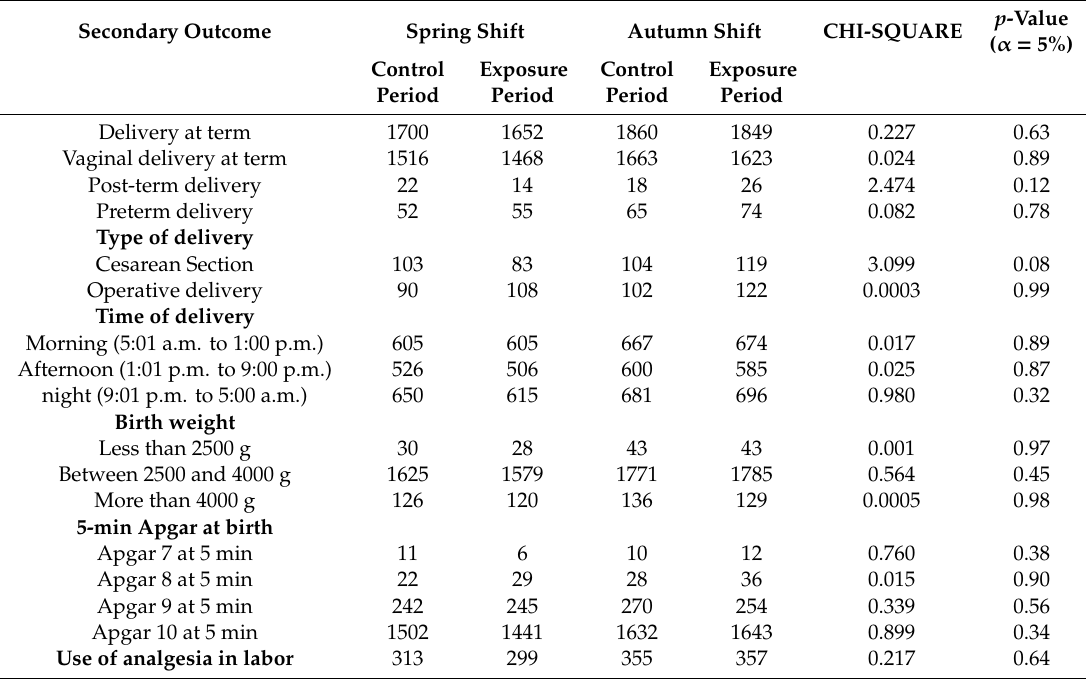
Table 4. Summarized data of results of secondary